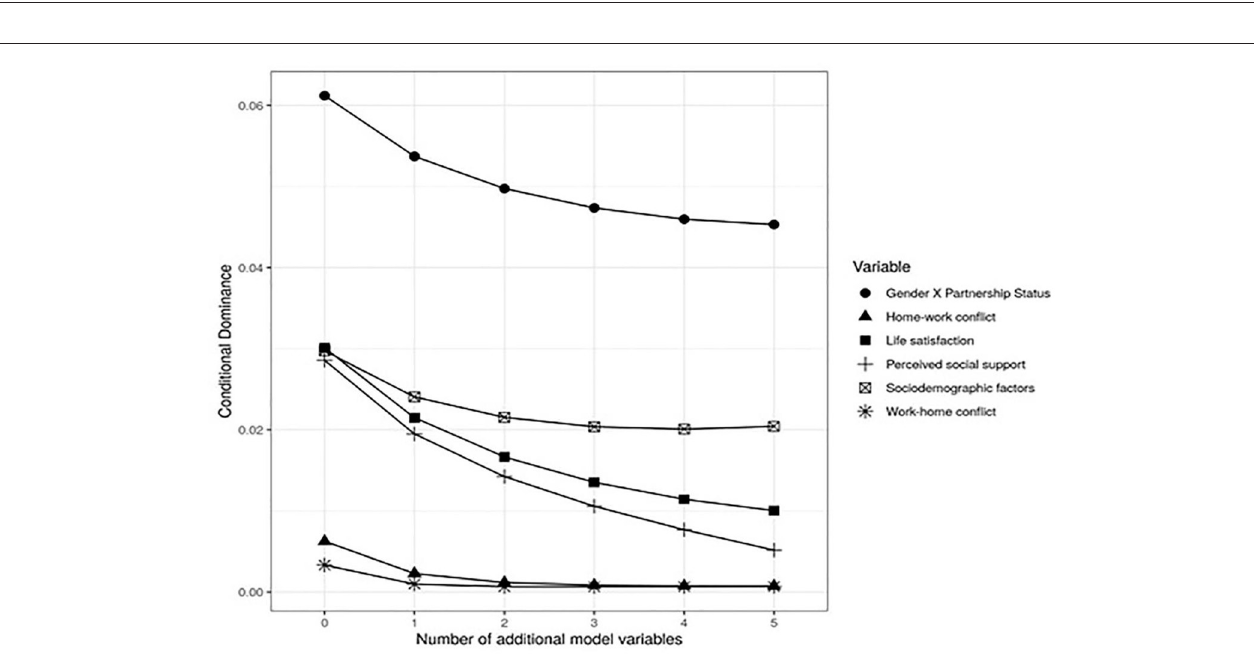
FIGURE 3 | Conditional dominance analysis of parental satisfaction with control variables, psychosocial predictors, and gender x partnership status moderation.